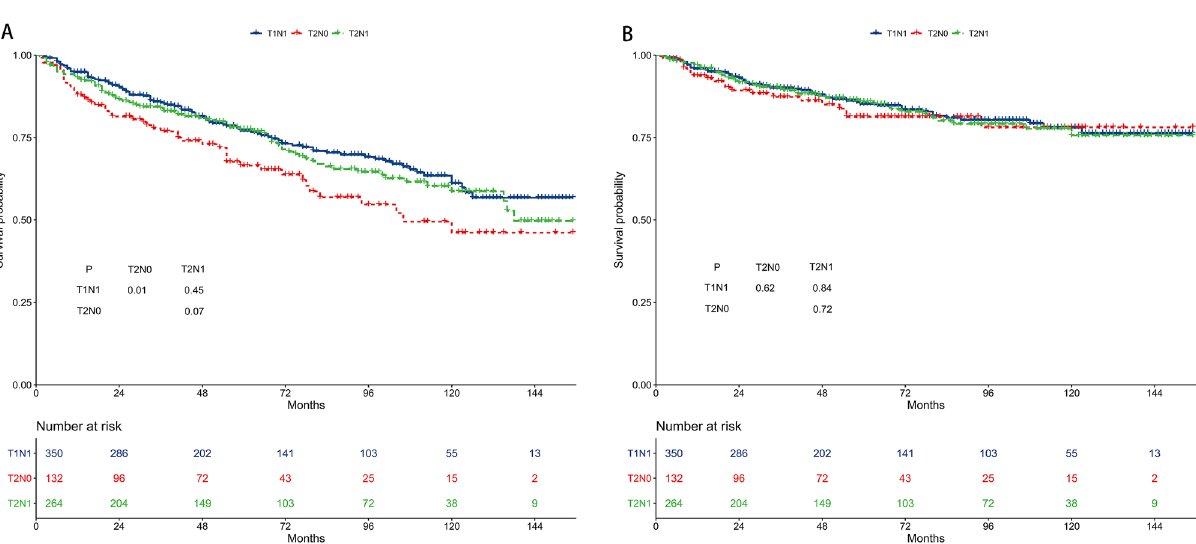
Figure 5. Survival outcomes of the T1N1, T2N0, and T2N1 subgroups in the chemoradiotherapy group. ( A ) Overall survival. ( B ) Cancer-specific